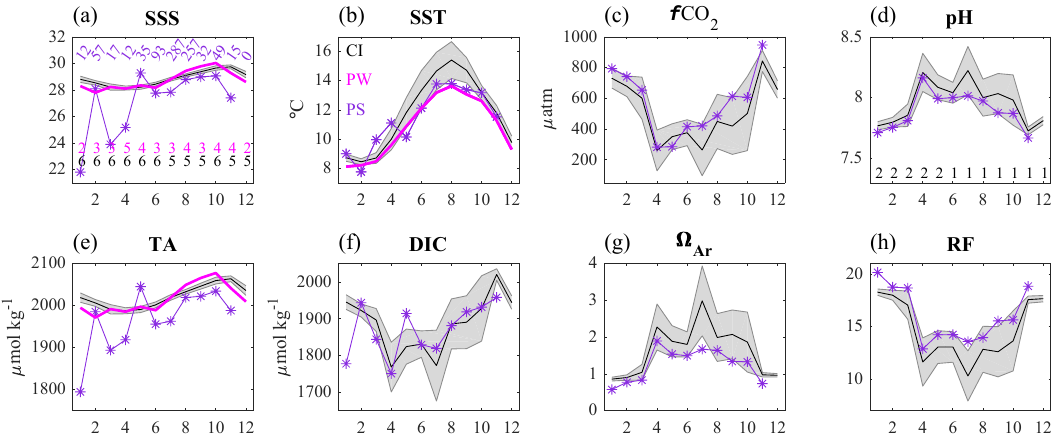
Figure D3. Seasonal cycles of (a) SSS, (b) SST, (c) f CO 2 , (d) pH T , (e) TA, (f) DIC, (g) (cid:127) Ar , and (h) RF at the Carr Inlet (CI) and Point Wells (PW) moorings and for the Puget Sound (PS) region. Gray shading shows ± 1 σ for CI. Text near the bottom of (a) indicates the number of years of moored SSS and SST observations contributing to the monthly seasonal cycle estimates. Text in (d) indicates the same information but for the moored pH observations. Slanted text in (a) indicates the total number of discrete observations contributing to the monthly seasonal cycle